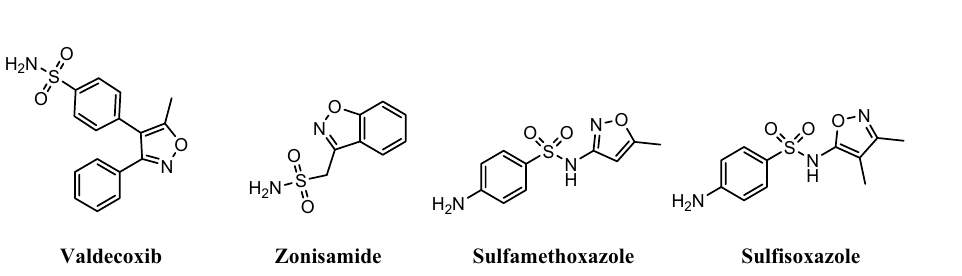
Figure 2. Structure of biologically active sulfonamide-isoxazole